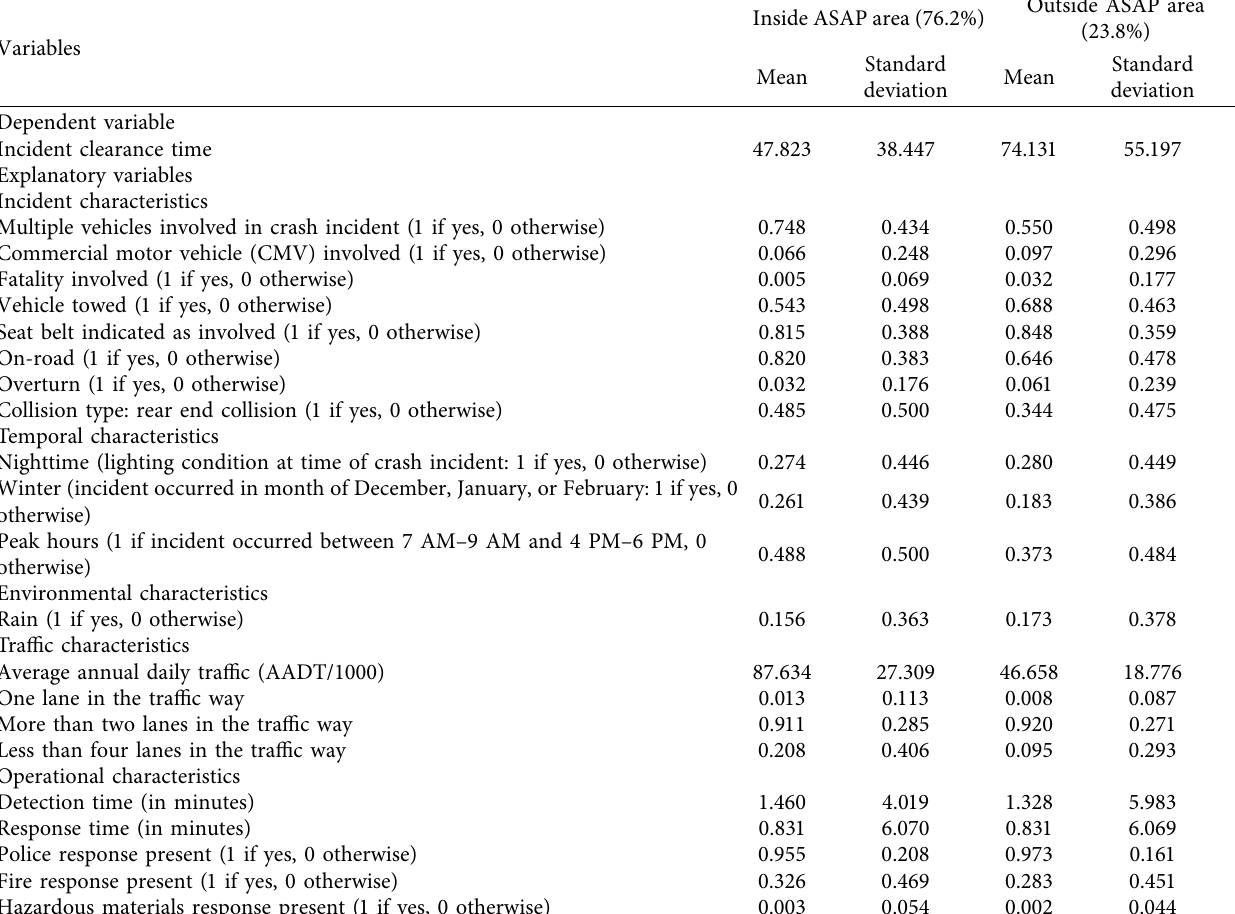
Table 1: Descriptive statistics of the variables included in the random parameters duration models.